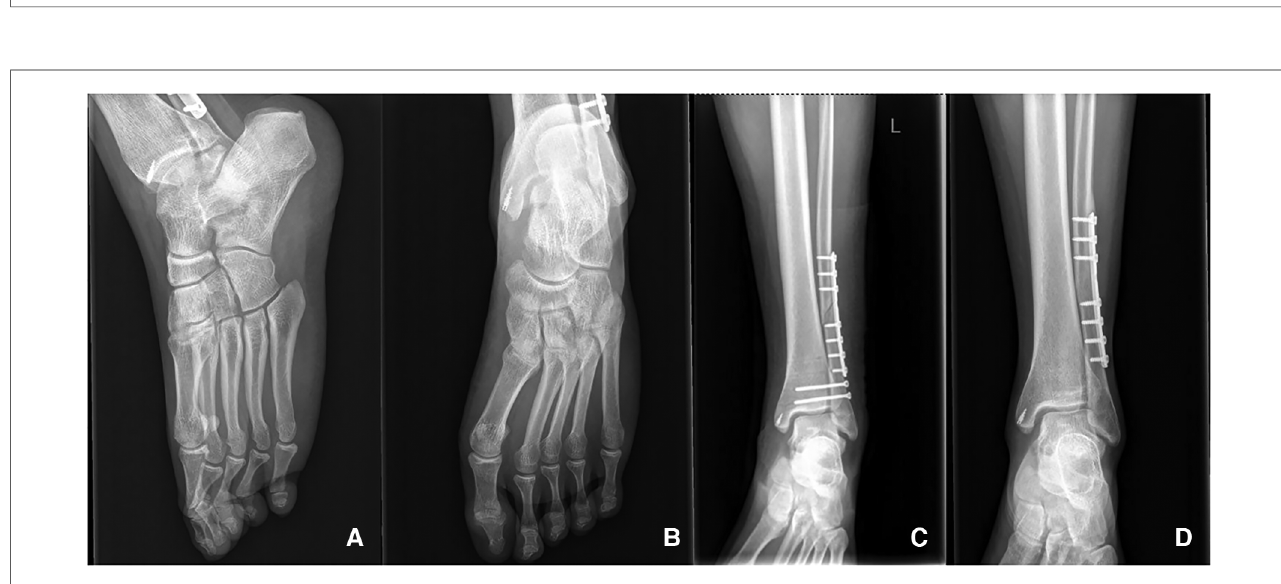
FIGURE 1 X-ray ( A , anteroposterior view and B , lateral view) and 3D reconstruction of a CT scan ( C ) of a primary left ankle injury. Radiographic evaluation con fi rmed the diagnosis of a Lauge – Hansen PER stage IV malleolar